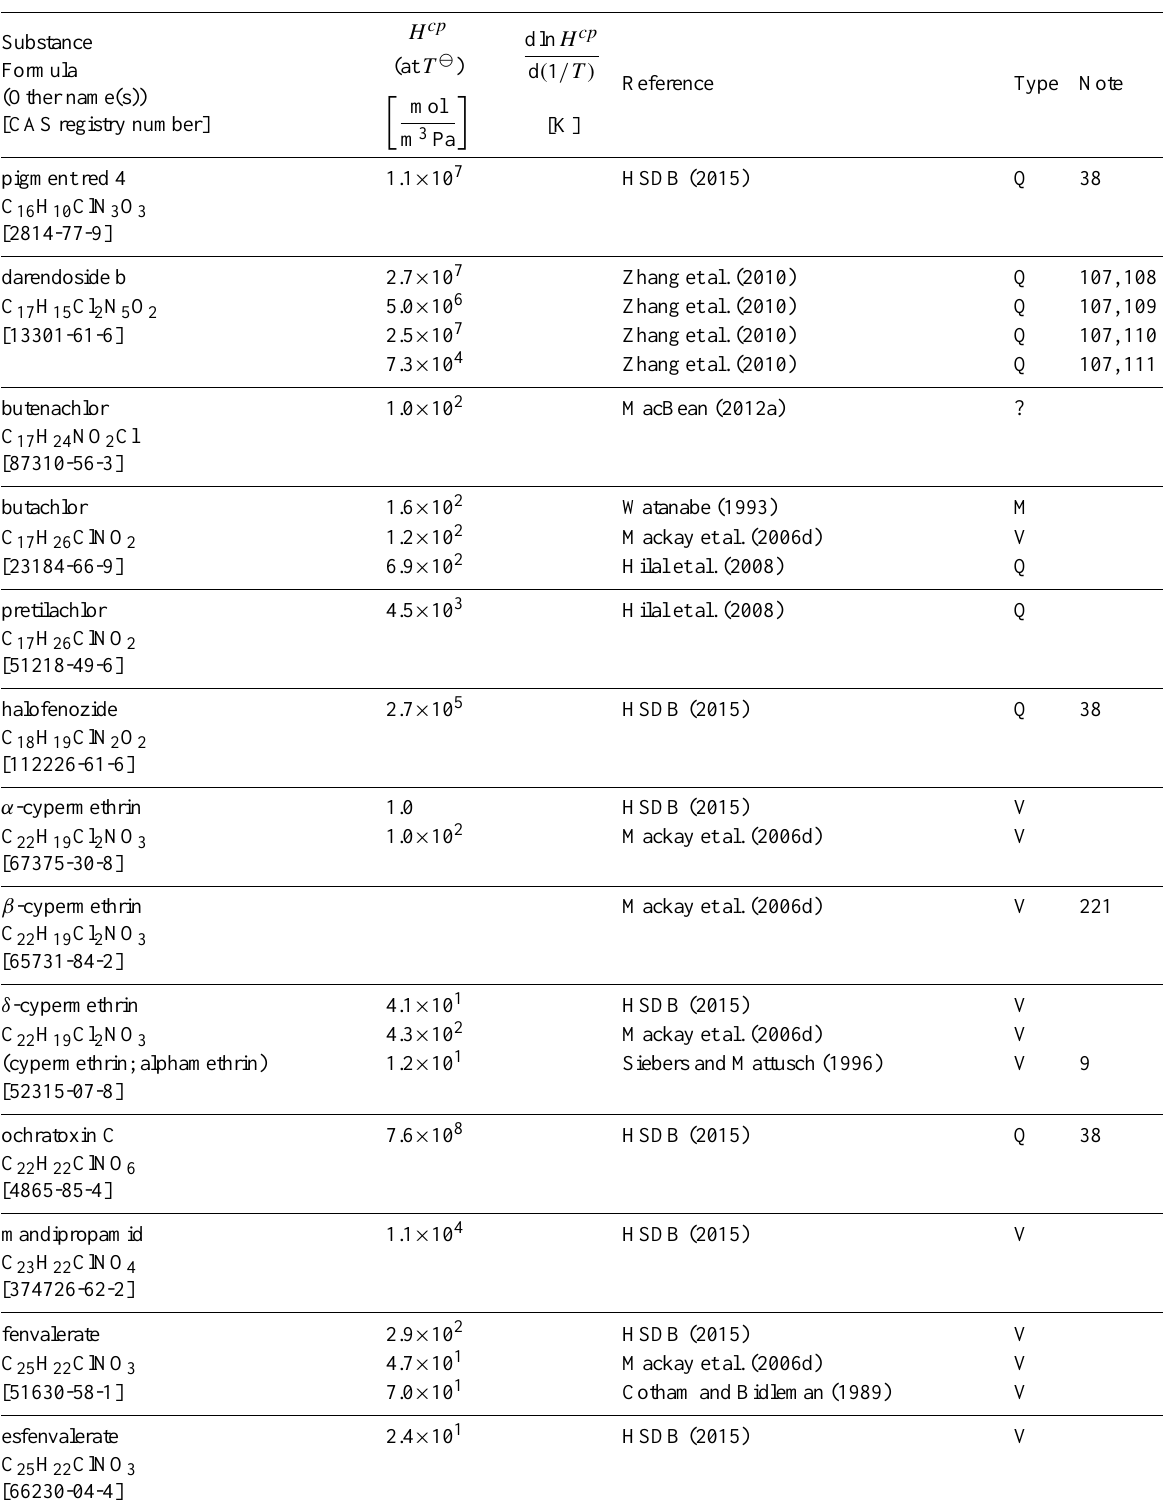
Table 6: Henry’s law constants for water as solvent